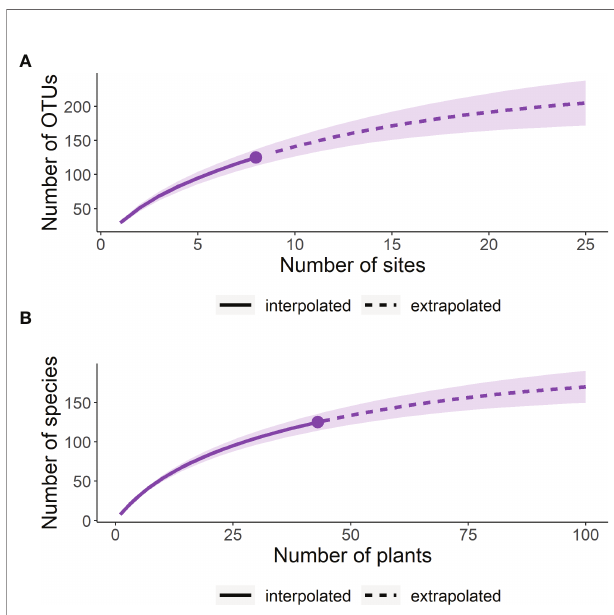
FIGURE 3 | Taxonomic diversity (A) and distribution of functional guilds (B) across hosts and sites. The proportion of cultures identi fi ed to each order (A) or guild (B) is shown for each host at each